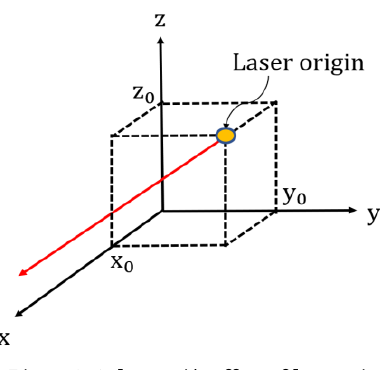
Figure 1. A laser with offset of laser origin